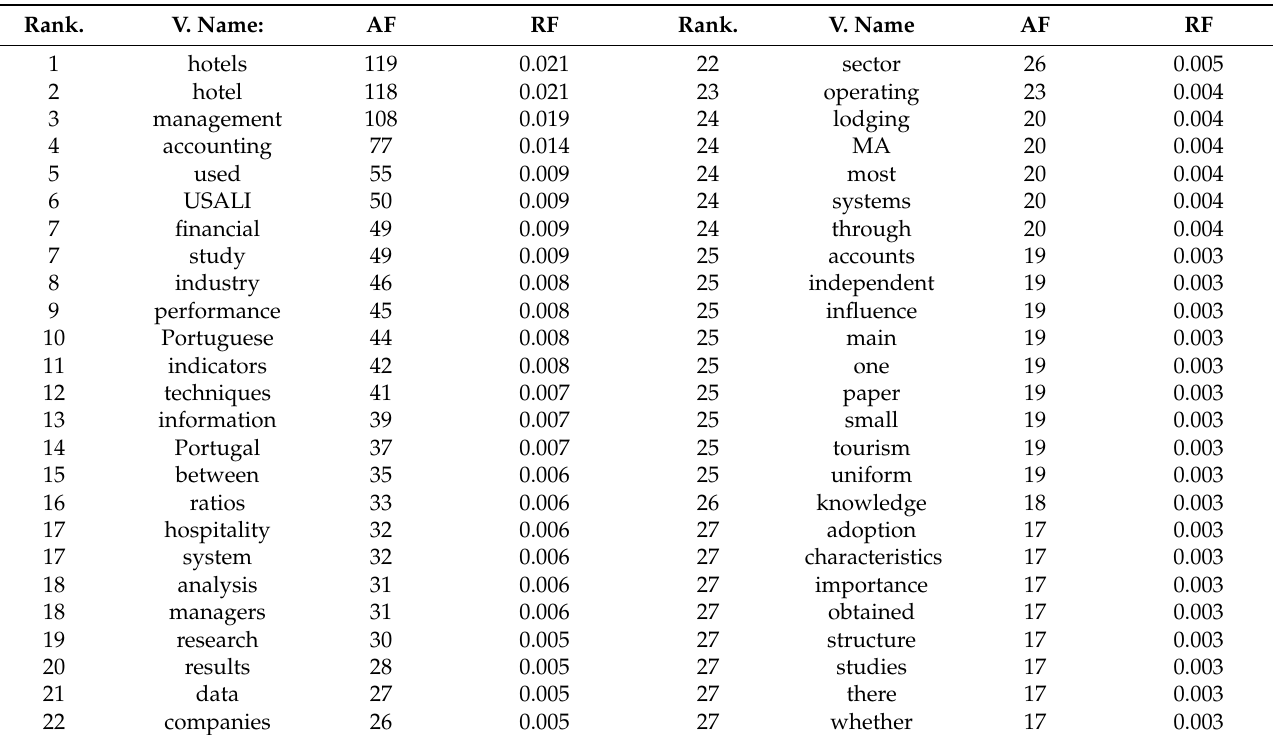
Table 2. Top 50 most frequent topics.